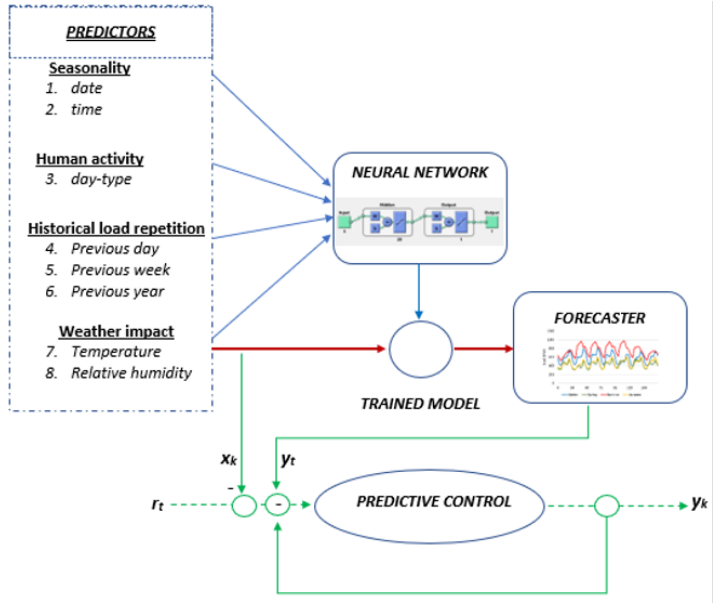
Figure 7. The proposed real-time load forecast